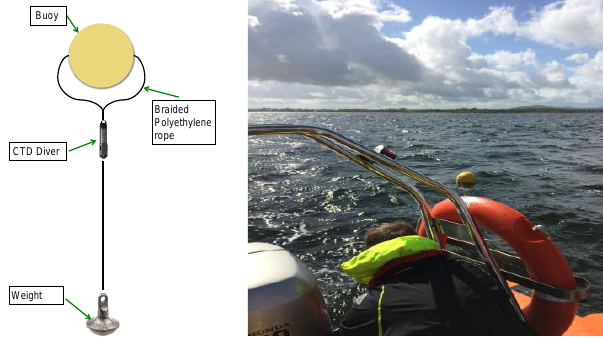
Figure 4. Schematic diagram of the sampling rig set up ( left ) showing the CTD Diver sensor attached to a float using a 2 mm braided polyethylene rope with a weight fixed at the bottom to keep the sensor in a vertical position. The float can be seen ( right ) slightly left of centre during a sensing transect of the bay.